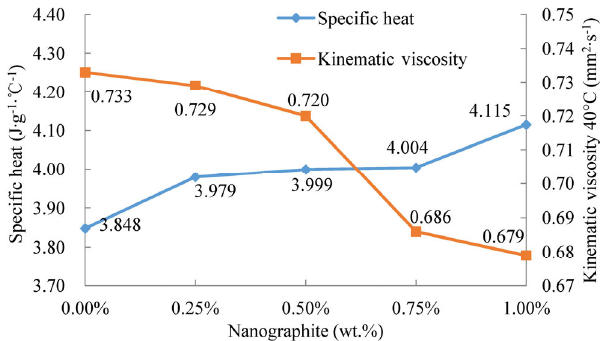
Fig. 9 Variation in the specific heat and kinematic viscosity of WOS-G cutting fluids at 40 °C.